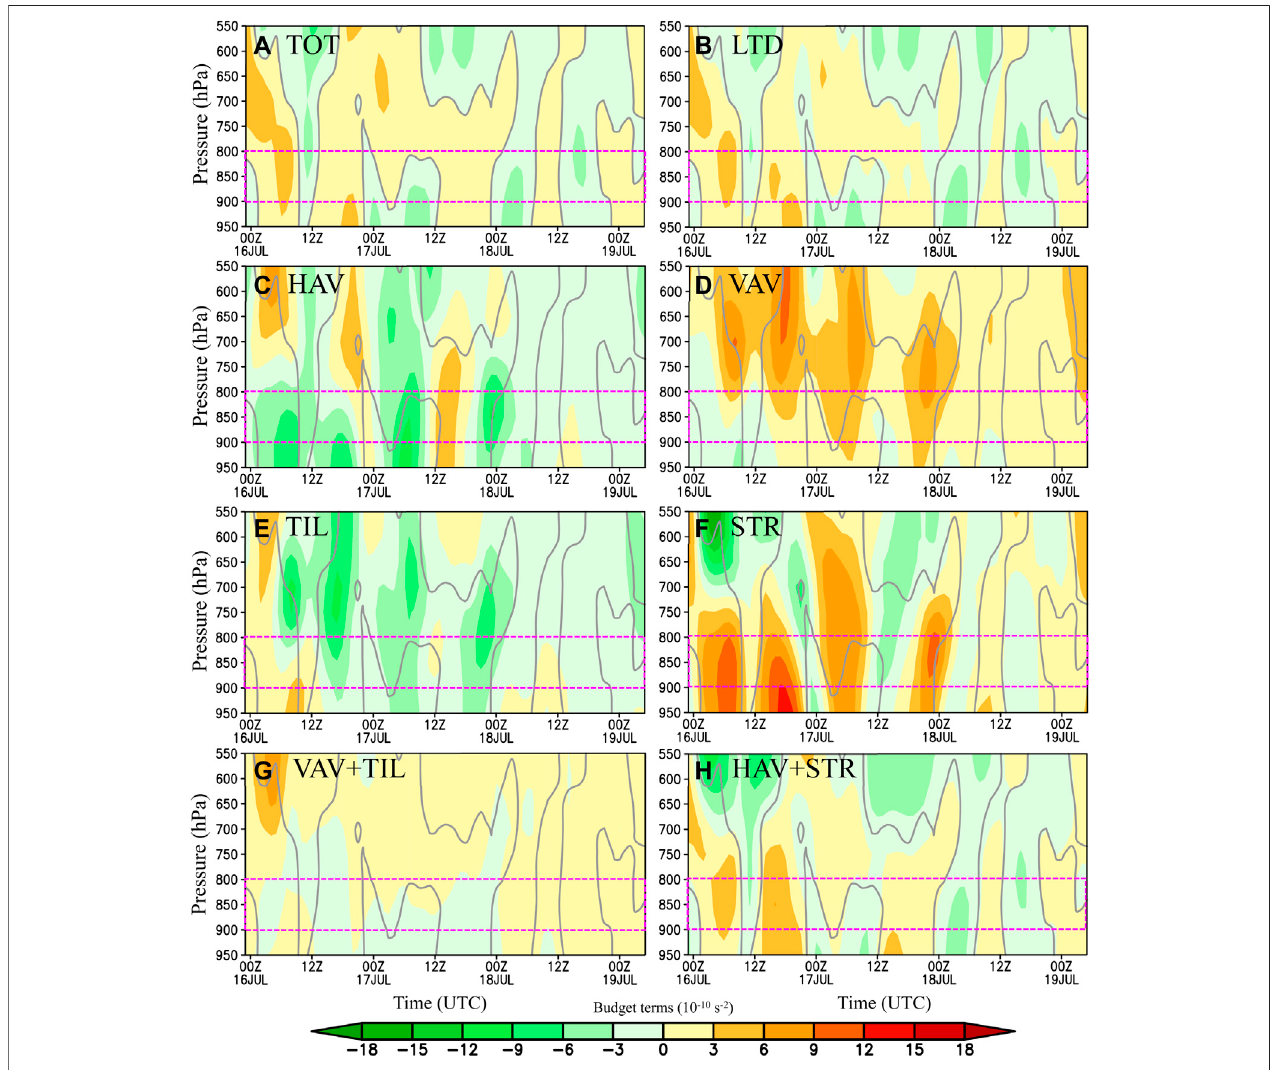
FIGURE7| Area-averaged(withinthemainbodyofthevortex)vorticitybudgetterms:TOT (A) ,LTD (B) ,HAV (C) ,VAV (D) ,TIL (E) ,STR (F) ,VAV+TIL (G) ,andHAV + STR (H) , where the purple dashed lines outline the central level of the vortex and the thick gray contour is the zero contour of term TOT. LTD, local time derivative.